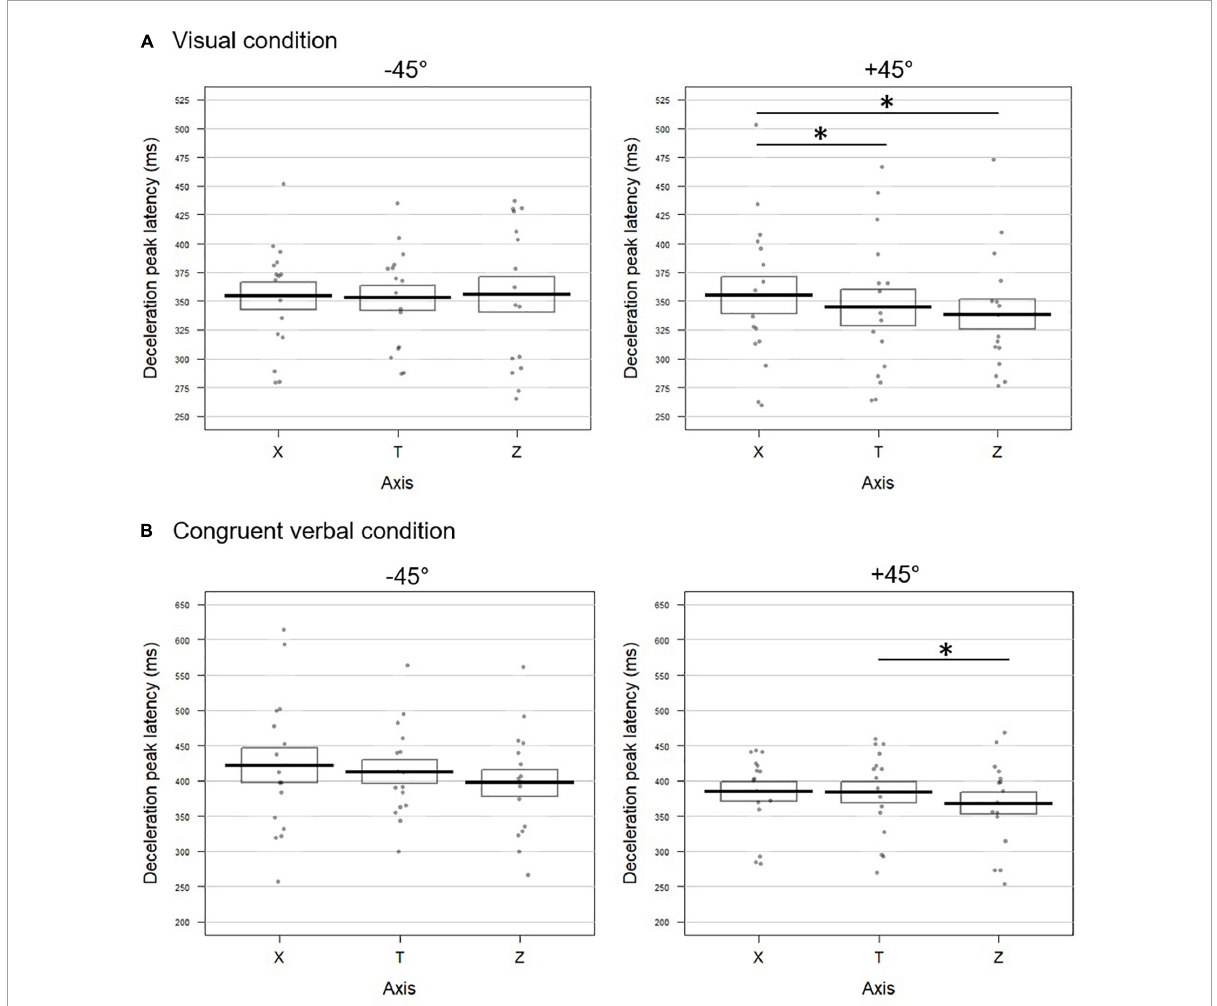
FIGURE3 Temporal dynamic of the movements toward –45 ◦ (left panel) and +45 ◦ (right panel) targets upon (A) visual and (B) congruent verbal instructions in Experiment 1. Latencies (in milliseconds) of the deceleration peak along the horizontal (X), tangential (T), and vertical (Z) axes are reported. The bold lines represent peak latencies averaged across participants for each axis, rectangles illustrate the standard errors. Each dot stands for the mean peak latency for one participant in the corresponding condition. Significant difference between conditions are represented by *. (A) When pointing toward +45 ◦ visually cued targets, the deceleration peak occurred later on X than on T ( t = 2.35; p = 0.032) and Z ( t = –2.91; p = 0.016). (B) For movements toward +45 ◦ targets following verbally congruent instructions, earlier deceleration was found on Z than on T ( t = –2.66; p = 0.018) and the effect approached significance for the comparison between Z and X ( t = –2.01; p =